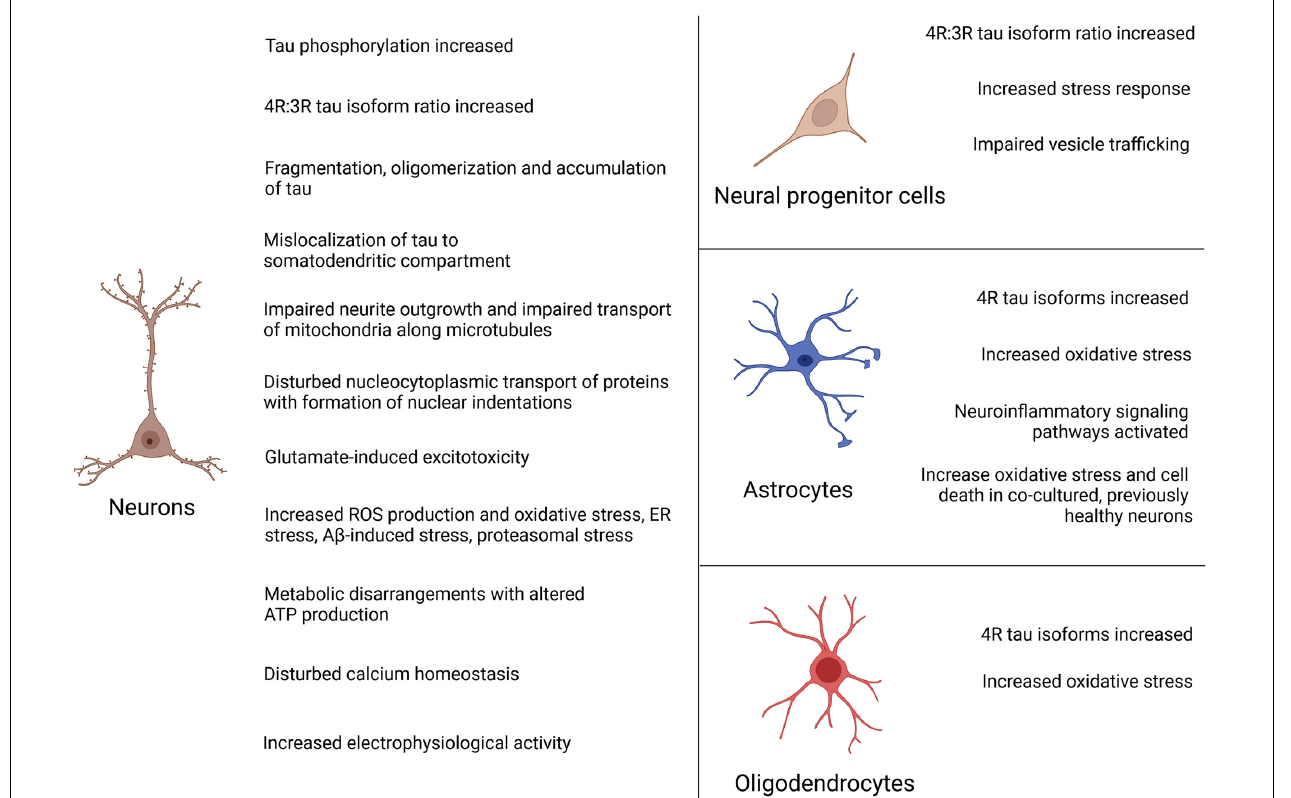
FIGURE 4 | Summary of disease phenotypes in FTLD-tau iPSC-derived neural cells. Disease phenotypes have mainly been described in patient iPSC-derived neurons. In addition, pathologic changes have been reported in neural progenitor cells, astrocytes and